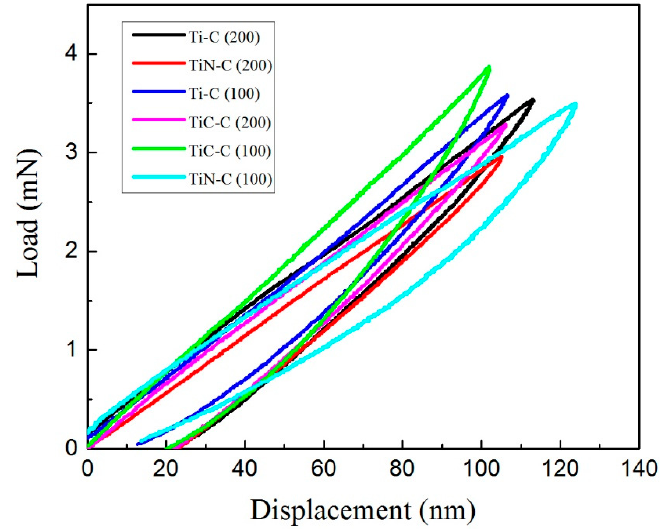
Figure 8. Nanoindentation load vs. indentation displacement curves of (Ti:N)-GLC films.